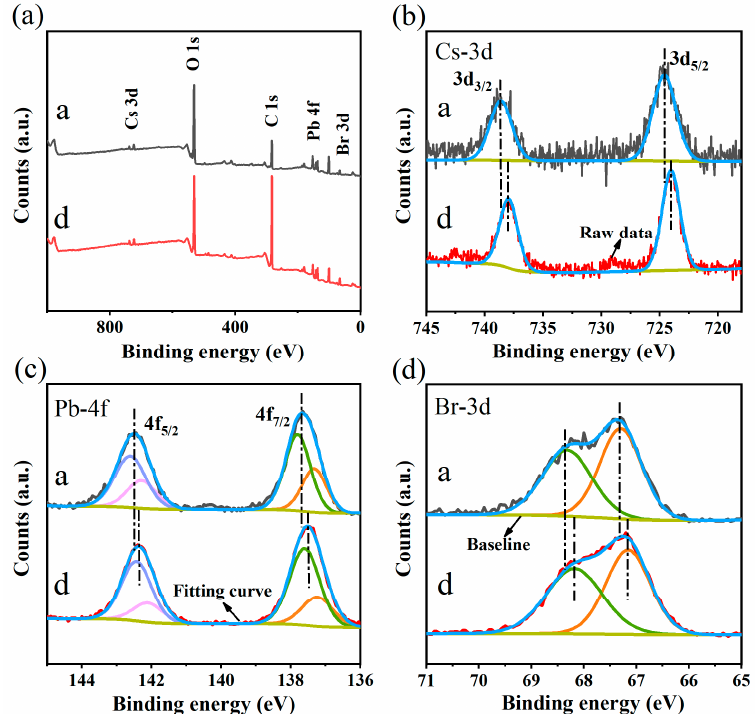
Figure 4. ( a ) XPS survey spectra of sample a film; ( b ) high-resolution XPS spectra of sample a and d at Cs; ( c ) high-resolution XPS spectra of sample a and d at Pb; ( d ) high-resolution XPS spectra of sample a and d at Br.